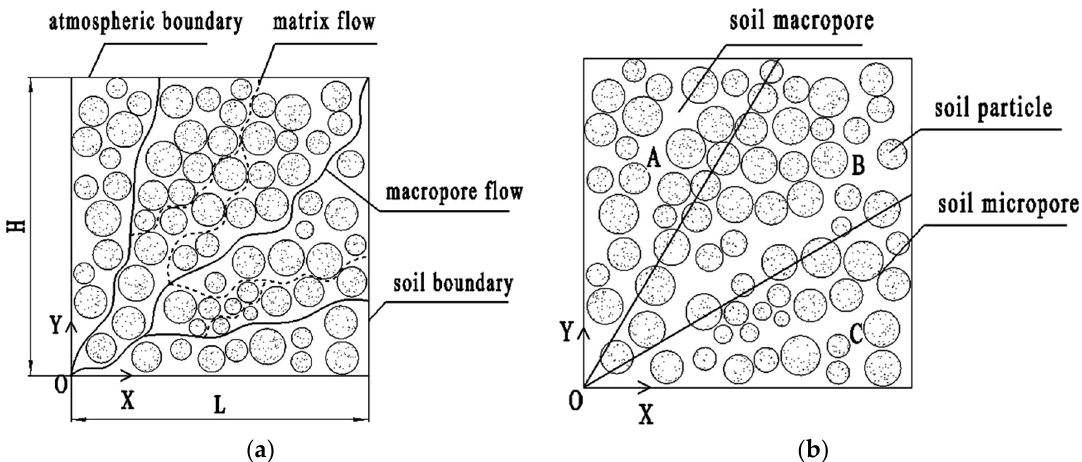
Figure 1. Schematic of steam heat transfer in large pores. ( a ) soil pore diagram; ( b ) heat transfer zone. Note: Point O is the heat source point of the steam, and L and H represents the horizontal and vertical diffusion distance of the steam heat flow.